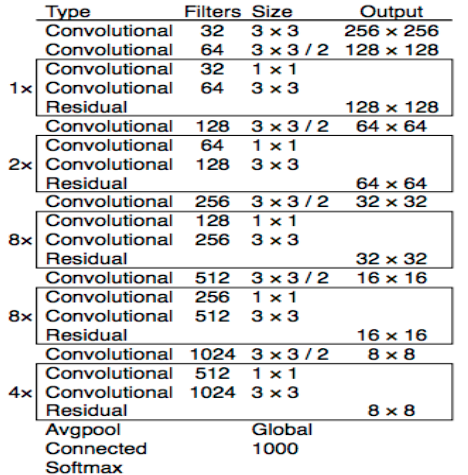
Figure 9. DarkNet-53 architecture [13].